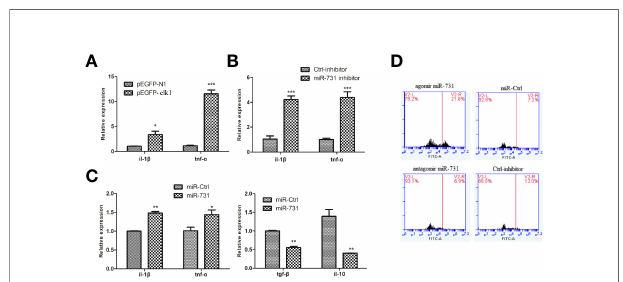
FIGURE 6 | C. idella Kidney cells (CIK) were transfected with either the pEGFP-elk1 (A) or miR-731 antagomir (B) . After 48 h, the level of il1b and tnfa expression was determined using qPCR. Macrophages were transfected with miR-731 agomir or antiagomir or control solution, and after 5h the macrophages were infected with A. hydrophila . The mRNA levels of il1b , tnfa , il10 , and tgfb (C) were analyzed by qRT-PCR 0.5 h after infection. (D) FITC fl uorescence in the macrophages were analyzed by the ImageStream imaging- fl ow platform. All values represent the mean ± SD of three independent experiments. Asterisks indicate signi fi cant differences (*p < 0.05, **p < 0.01, ***p <